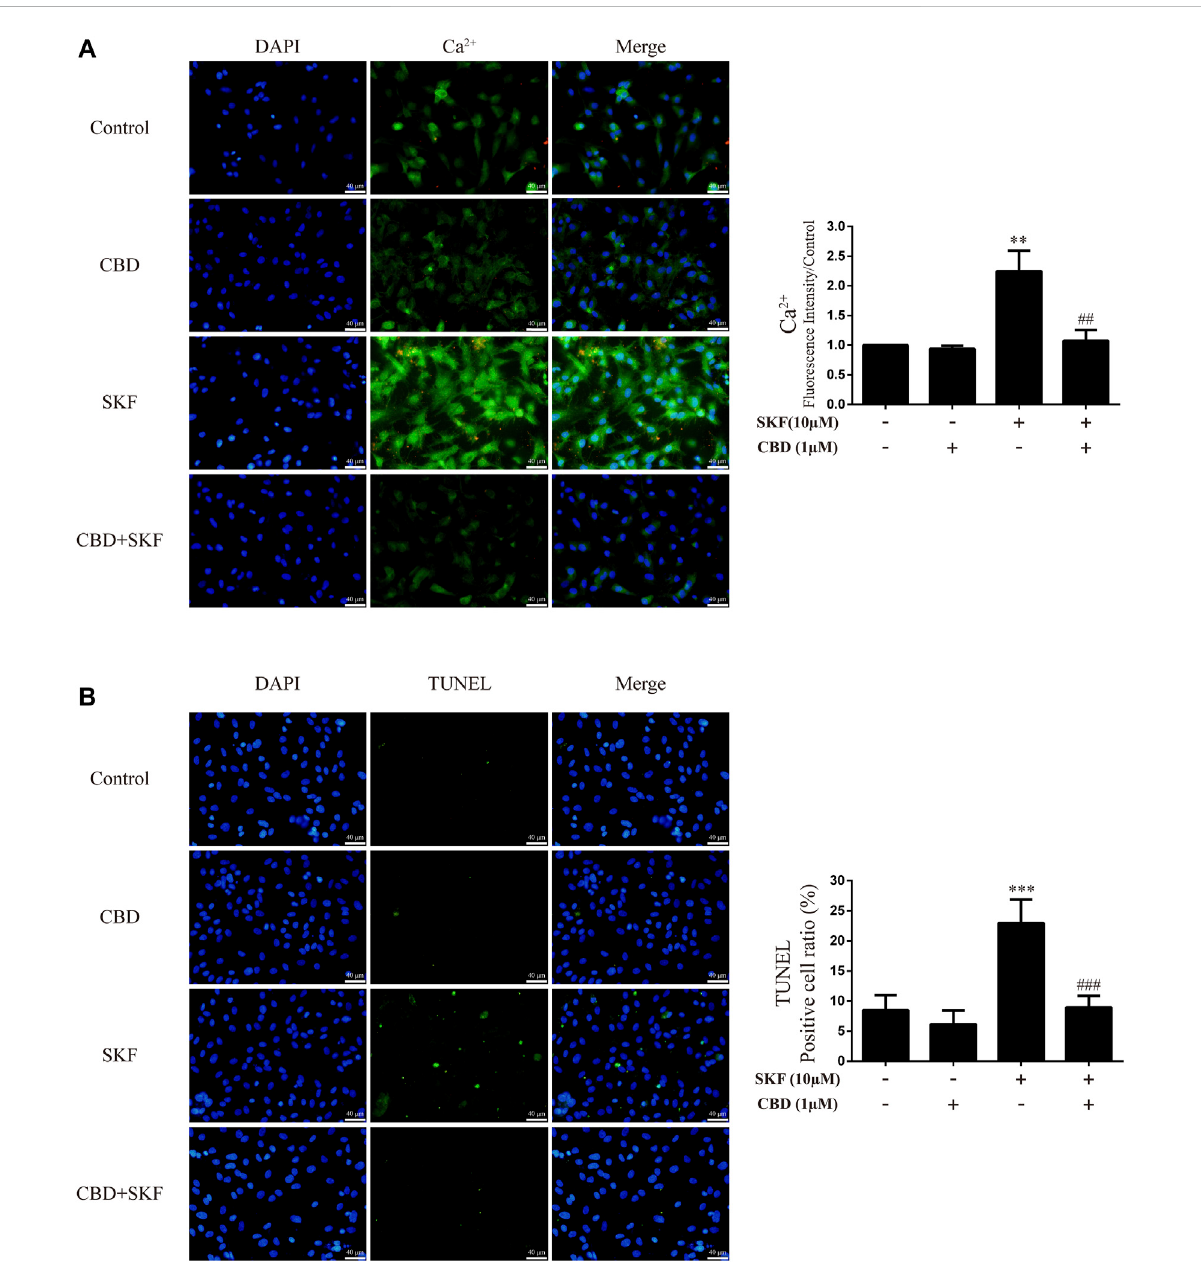
FIGURE 8 Intracellular Ca 2+ and apoptosis levels in neurons incubated with CBD and/or SKF81297. (A) Apoptosis level in neurons. (B) Intracellular Ca 2+ level in neurons. ** p < 0.01 or *** p < 0.001 compared with control group, ## p < 0.01 or ### p < 0.001 compared with METH group; Tukey HSD post- hoc comparison after signi fi cant